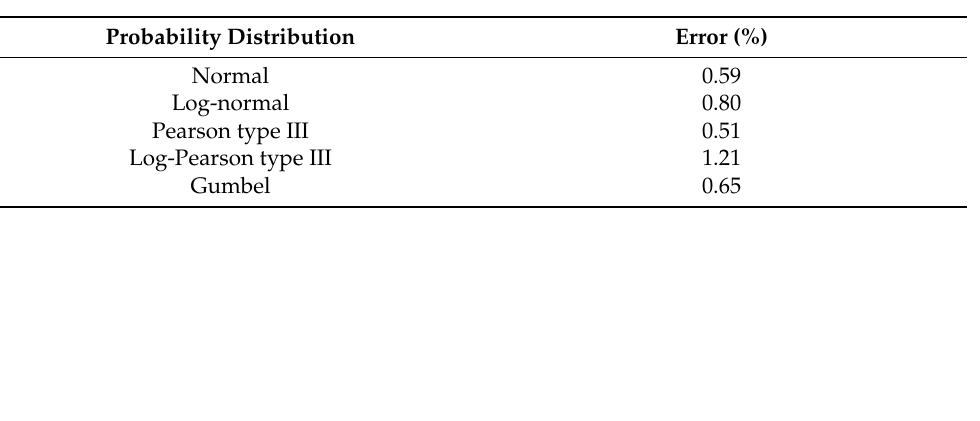
Table 7. Error of different statistical distributions in Low Flow Indices